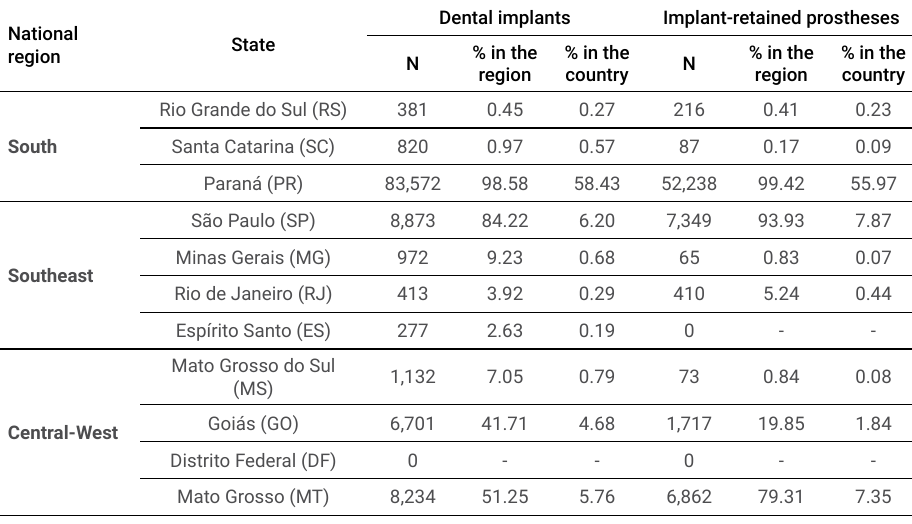
Table 1. Descriptive analysis stratified by state, considering the number of installed dental implants and number of installed dental prosthesis: DATASUS* (January 2010 to December 2019). National region